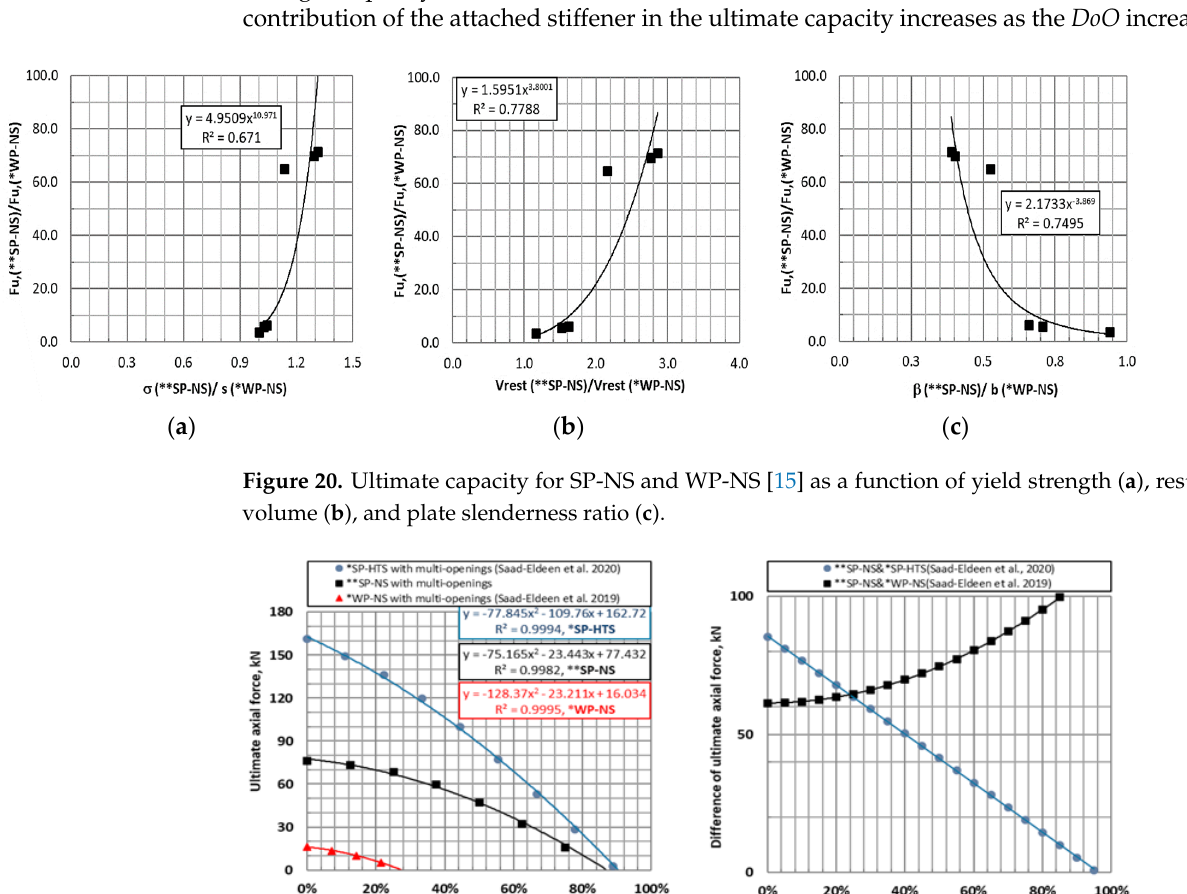
Figure 21. Ultimate axial force as a function of DoO ( a ) and trend of the capacity difference for SP- NS, * WP-NS of [15] and * SP-HTS of [18], 𝑤 (cid:3042) ∈ [0,3] mm ( b ).